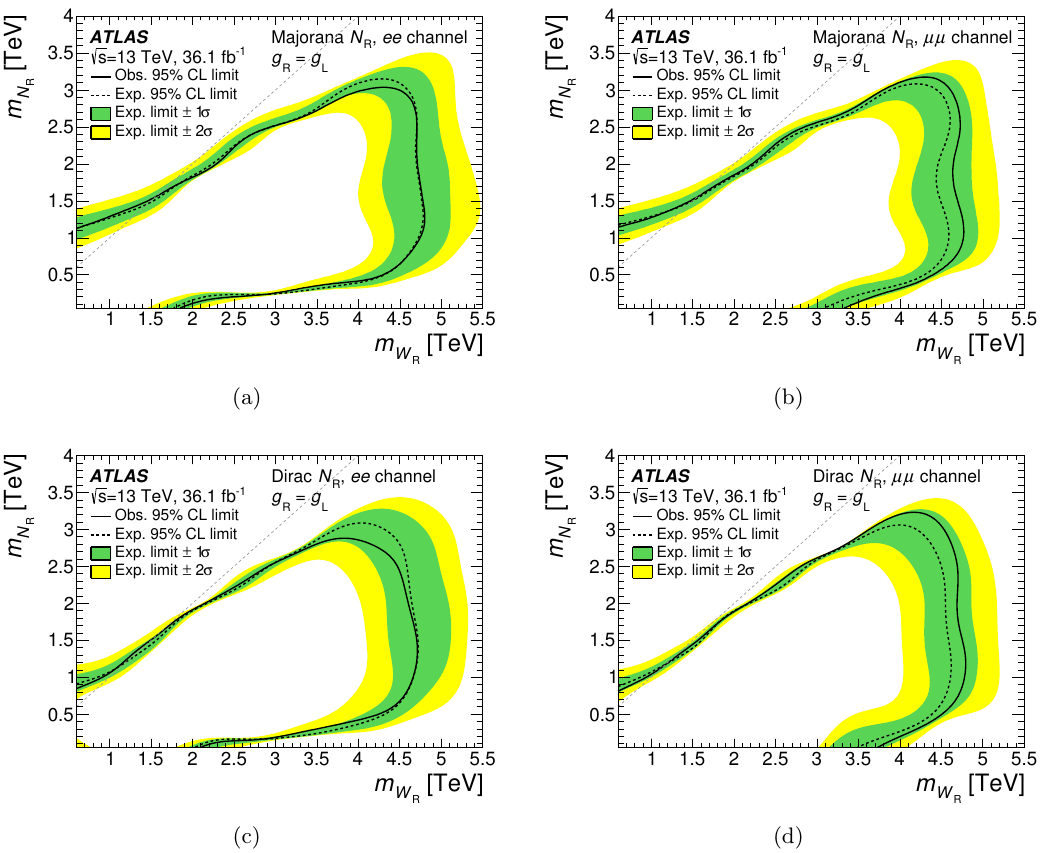
Figure 7 . Observed (continuous line) and expected (dashed line) 95% CL exclusion contours in the m W { m N plane, along with the one- and two-standard-deviation uncertainty bands around R R the expected exclusion contour in the (a) ee and (b) (cid:22)(cid:22) channels for Majorana N R neutrinos, (c) ee and (d) (cid:22)(cid:22) channels for Dirac N R neutrinos. The dashed gray line indicates the region of the plane where m W = m N . The left- and right-handed weak gauge couplings are assumed to be the R R same, as indicated by g L = g R